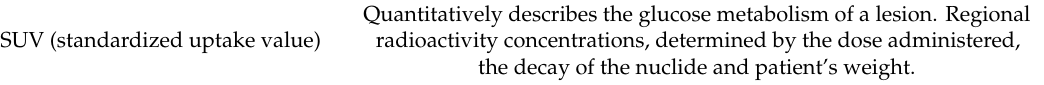
Table 1. Summary of quantitative biomarkers that can be derived from PET / CT